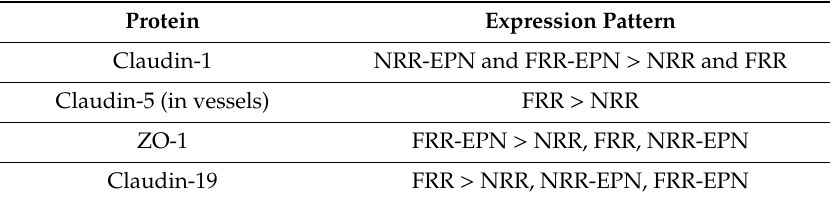
Table 1. Regional expression of tight junction proteins within rat DRGs. Neuron-rich region (NRR), fiber-rich region (FRR), epi- / perineurium (EPN).